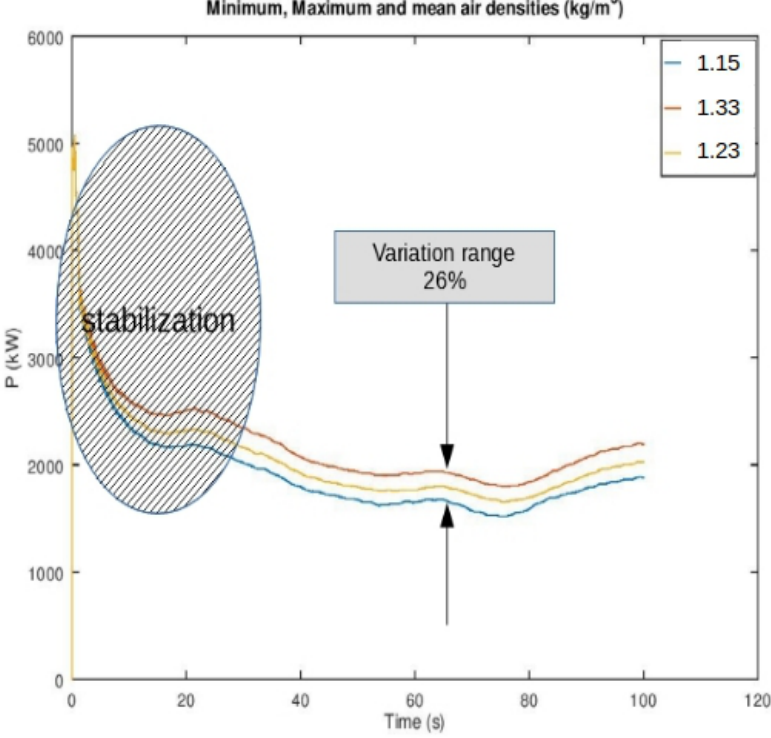
Figure 8. Simulation using FAST for the minimum, maximum, and mean air density values for the average wind speed at